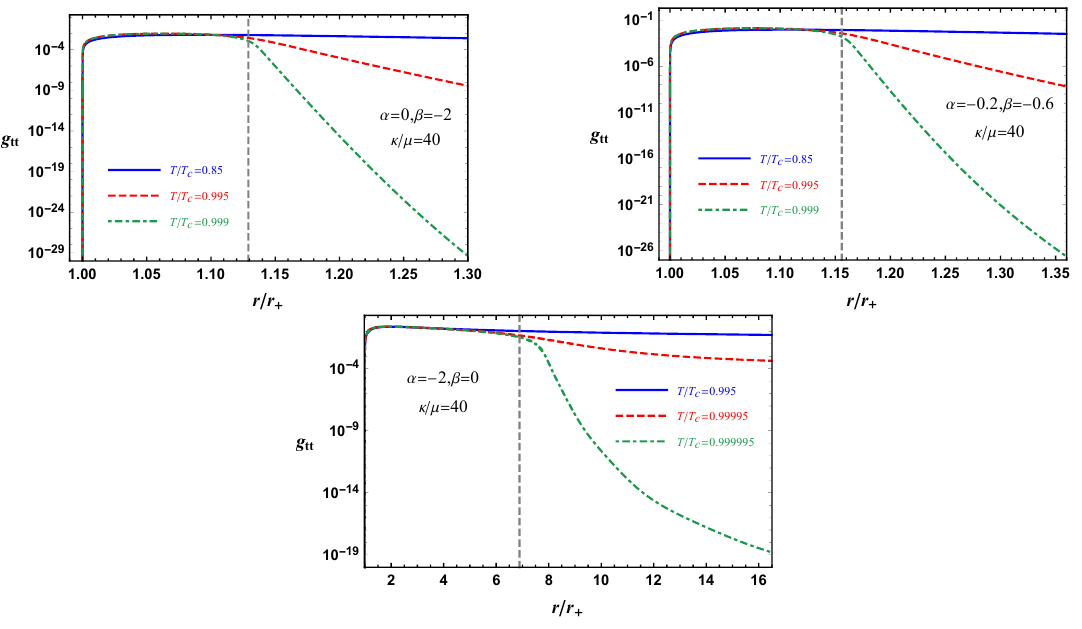
Figure 16 . The metric component g tt as a function of r near the would-be inner horizon (the vertical dashed line) for different temperature values. Here we take κ/µ = 40 .